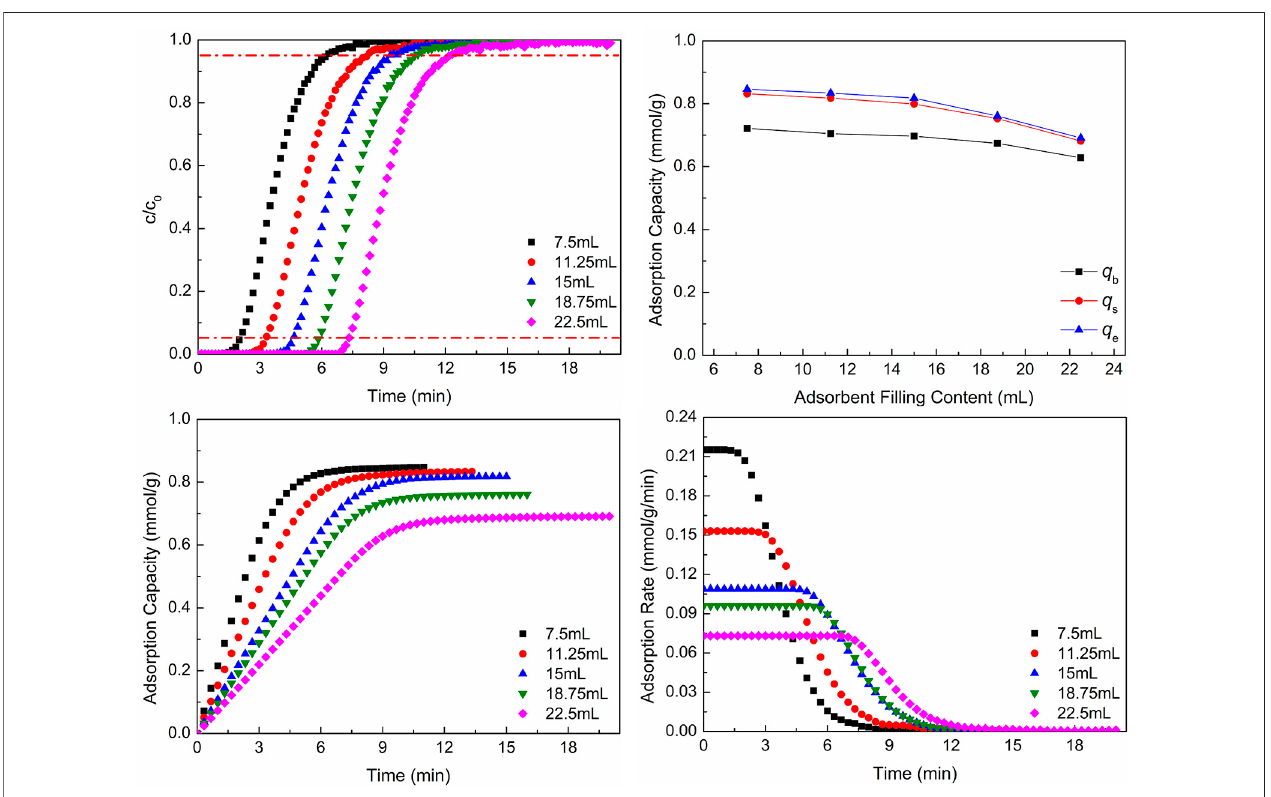
FIGURE 7 | CO 2 adsorption properties at different adsorbent fi lling contents: (A) breakthrough curves; (B) adsorption capacity; (C) adsorption process; (D) adsorption rate.